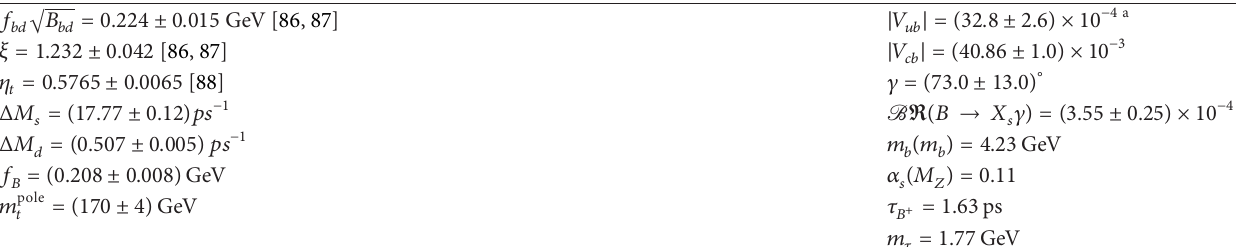
Table 1: Inputs used for the B-physics parameters in the analysis below. When not explicitly stated, we take the inputs from Particle Data Group [74].